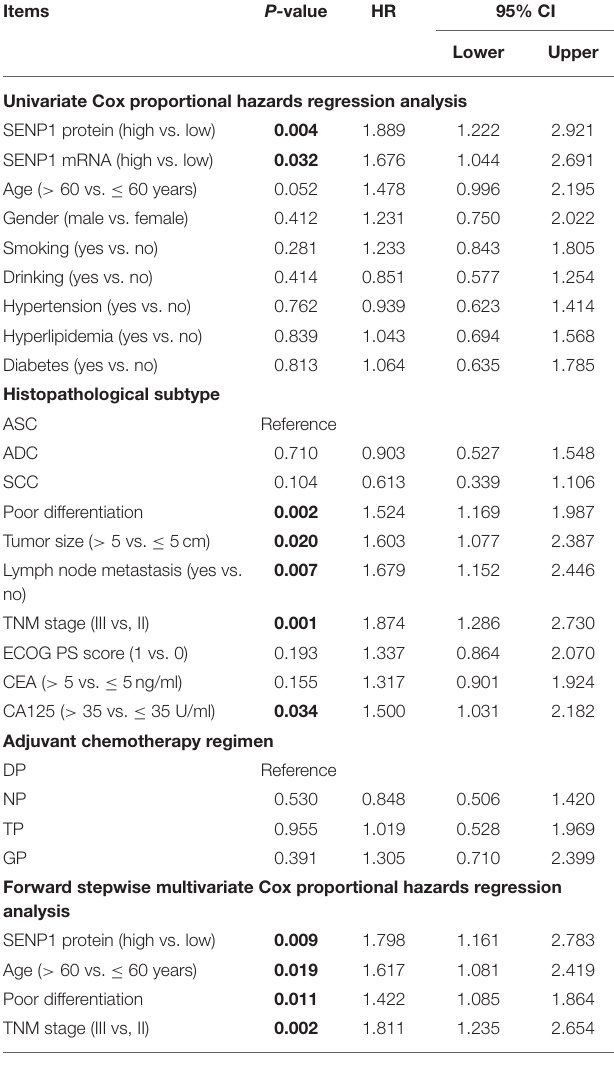
TABLE 3 | The Cox proportional hazards regression analysis for DFS. Items P- value HR 95% CI